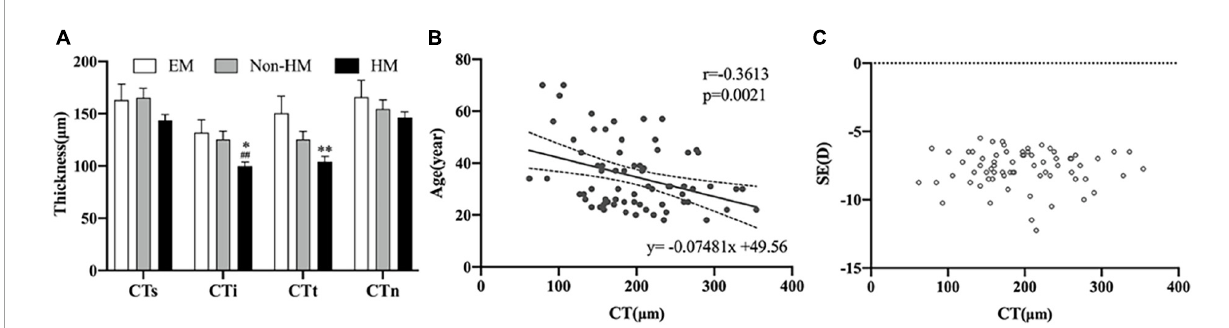
FIGURE4 Choroidal thickness of right eye. (A) Thickness in three groups. (B) Scatter plot of correlation between age and CT. (C) Scatter plot of correlation between SE and CT. ∗∗ p < 0.01, compared with EM group; ## p < 0.01, compared with non-HM group. EM, emmetropia; HM, high myopia; CT, choroid thickness; SE, spherical equivalence; s, superior; i, inferior; t, temporal; n, nasal. ∗ p < 0.05.